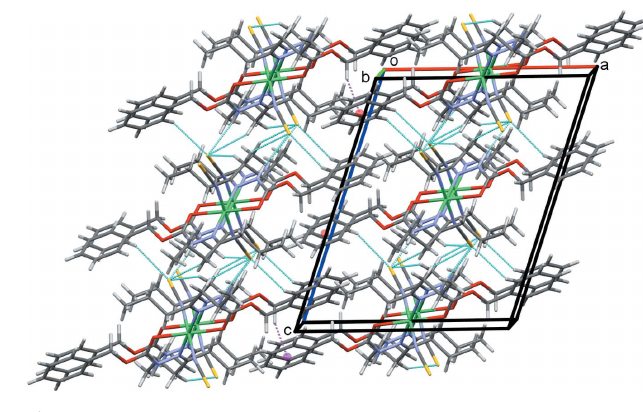
Figure 5 Overall packing of 1 viewed along the b -axis